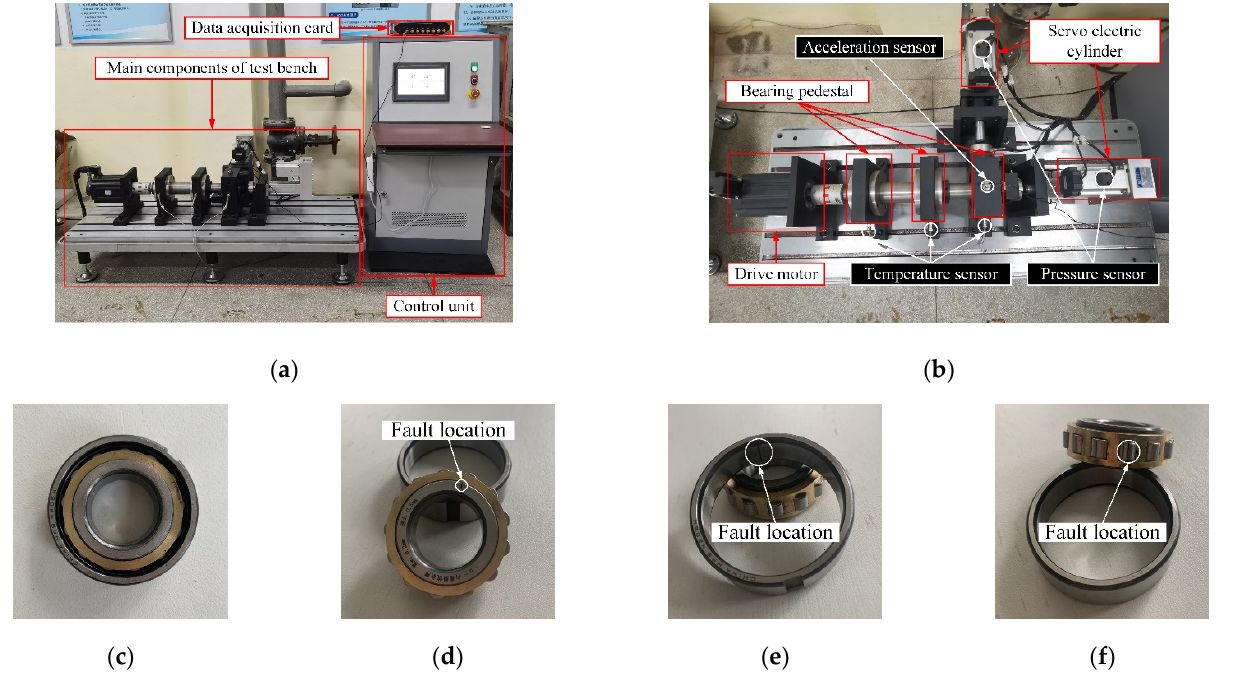
Figure 11. Test materials, ( a ) general layout of test stand, ( b ) schematic of the main structure of test stand, ( c ) normal bearings, ( d ) inner ring cracked bearings, ( e ) outer ring cracked bearings, ( f ) roller cracked bearings.